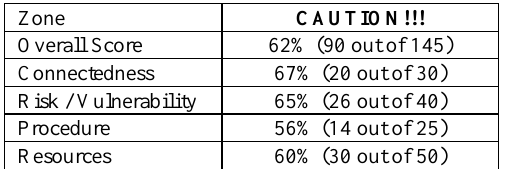
Table 3. Score obtained by the community in Torrens Community Disaster Resilience Scorecard